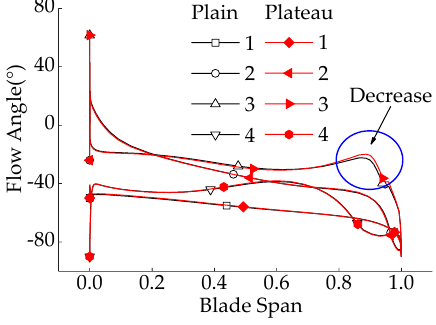
Figure 16. Distribution of flow angle at different impeller positions.